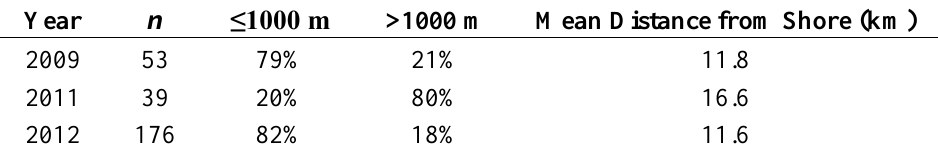
Table 2. Percentage of opportunistic blue whale sightings in waters ≤1000 m vs. >1000 m depth and mean distance from shore for 2009, 2011 and 2012.